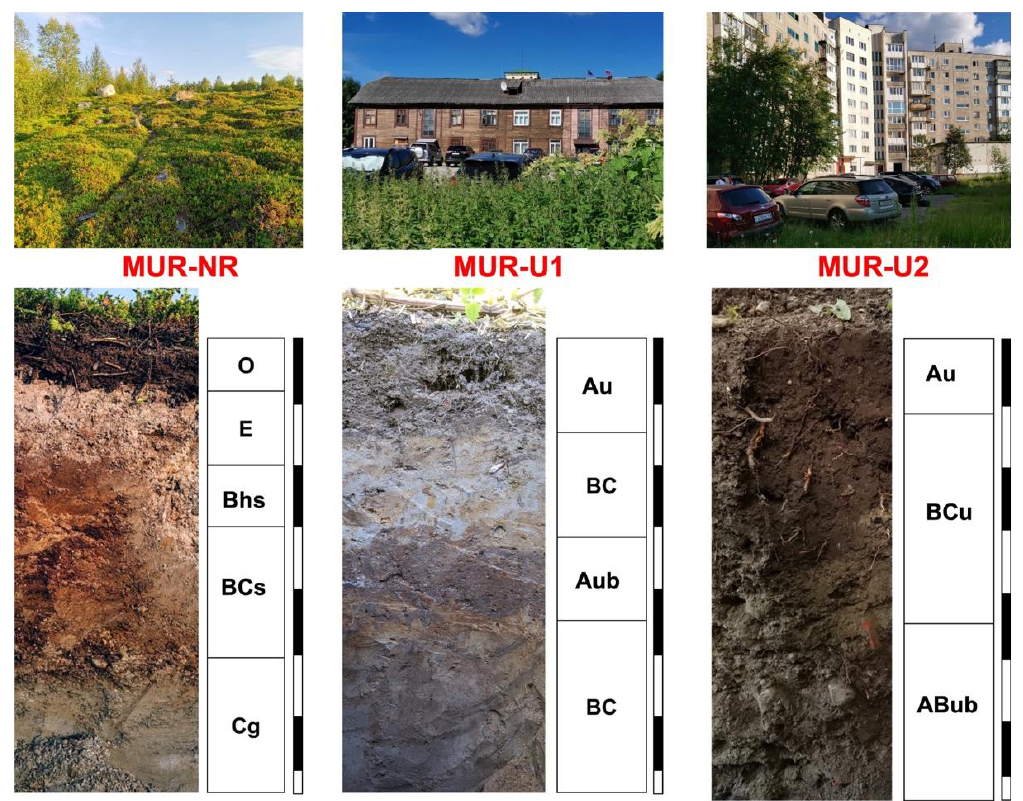
Figure 2. Sampling locations and soils profiles (black and white lines correspond to 10 cm depths).